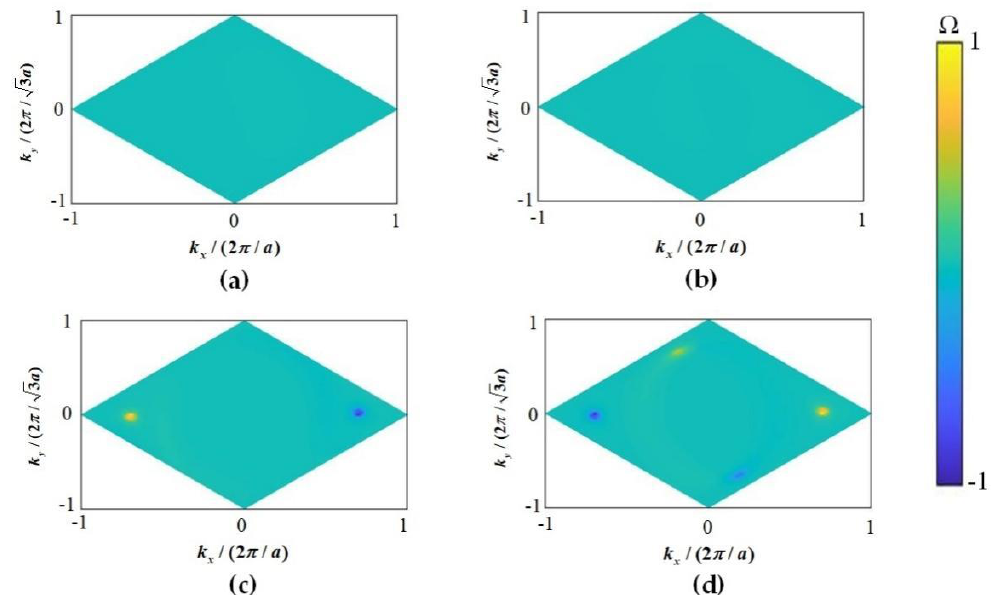
Figure 5. Berry curvature over the first Brillouin zone for each energy band of the spiral structure. ( a ) The first band ( b ) The second band ( c ) The third band ( d ) The fourth band.